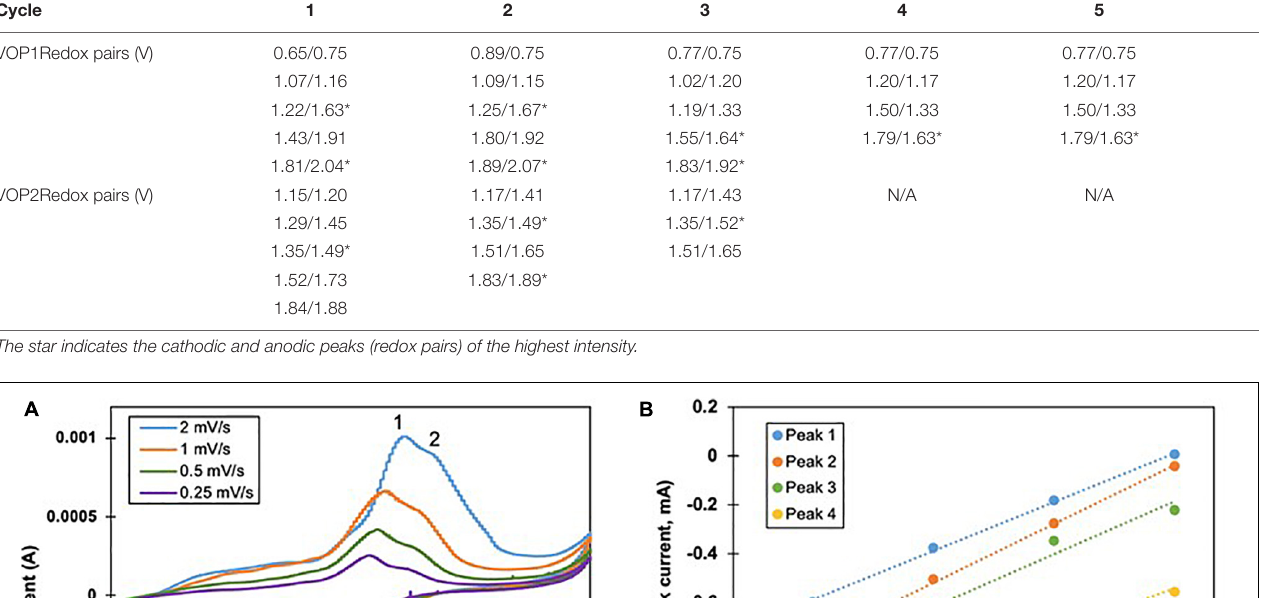
118.11, 271.38, and 375.67 ◦ C. These three peaks correspond with enthalpy of phase transition ( (cid:49) H) values of 44.47, 172.80, and 7.83 J/g, respectively. In a similar manner, two at 128.51 and 204.18 ◦ C with (cid:49) H values of 247.78 and 123.62 J/g,